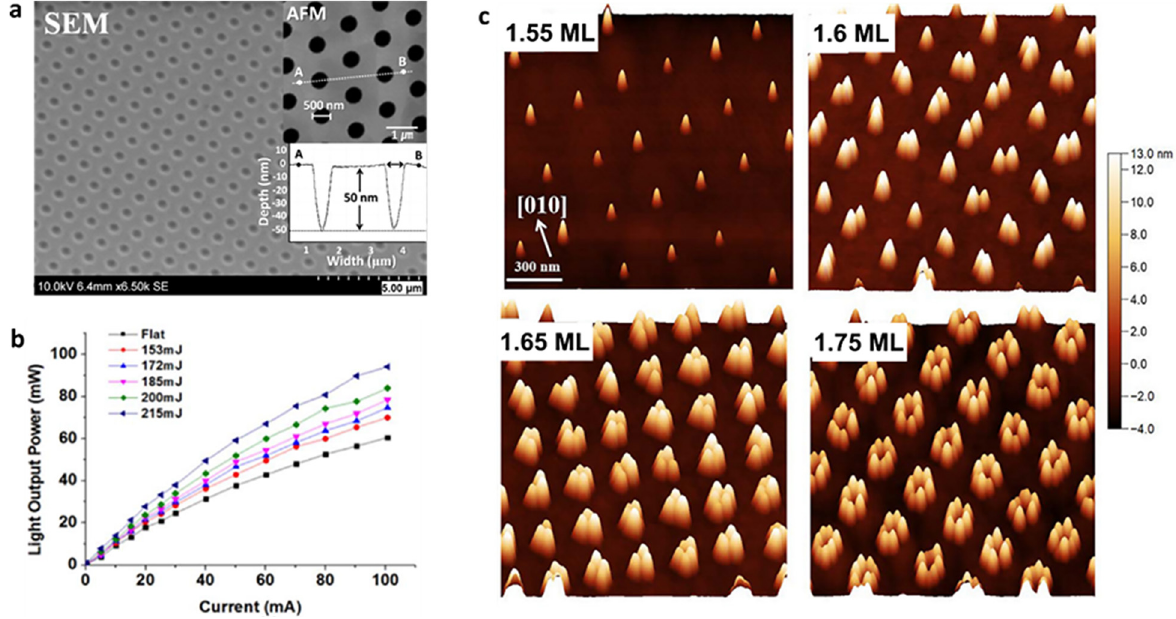
Figure 18: (a) Topography images of DLIP-treated LED based on GaN. (b) Optoelectronic characterization of structured LEDs, showing an increase in the performance. (c) AFM images of quantum dot arrays with different coverage of InAs monolayers (ML). Figures reproduced